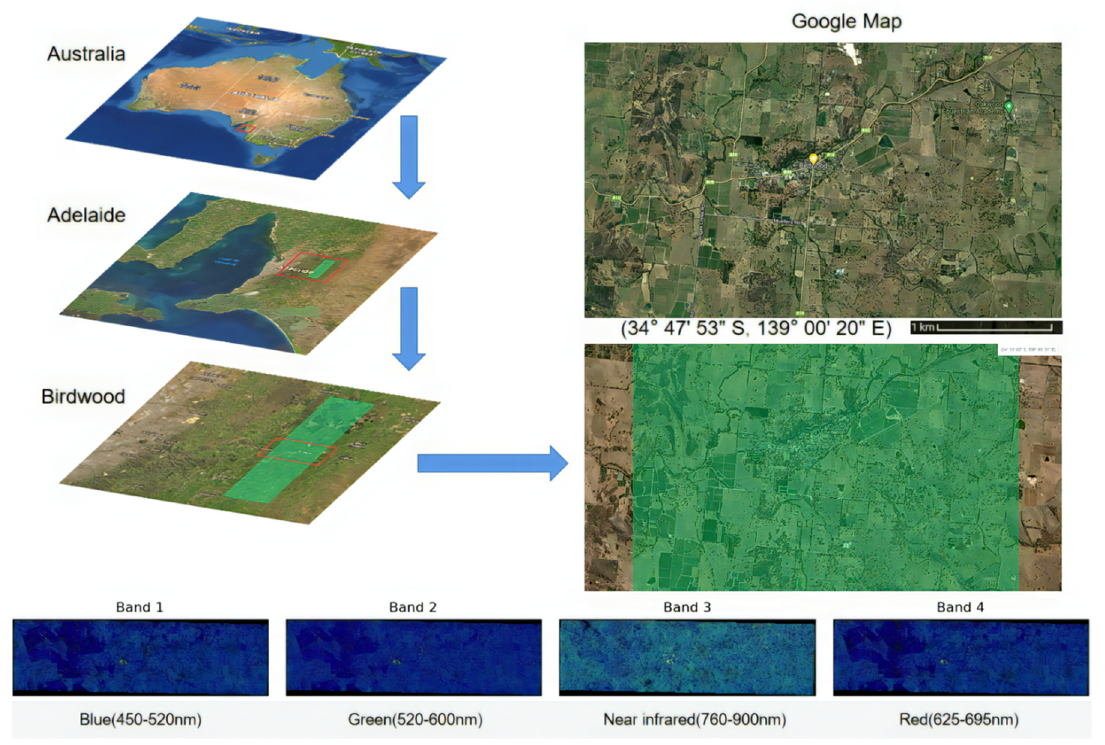
Figure 3. GeoEye’s OrbView – 3 satellite Dataset (The location is Birdwood, Adelaide, Australia). Table 3. The data types and features of the UAV and satellite referenced experimental